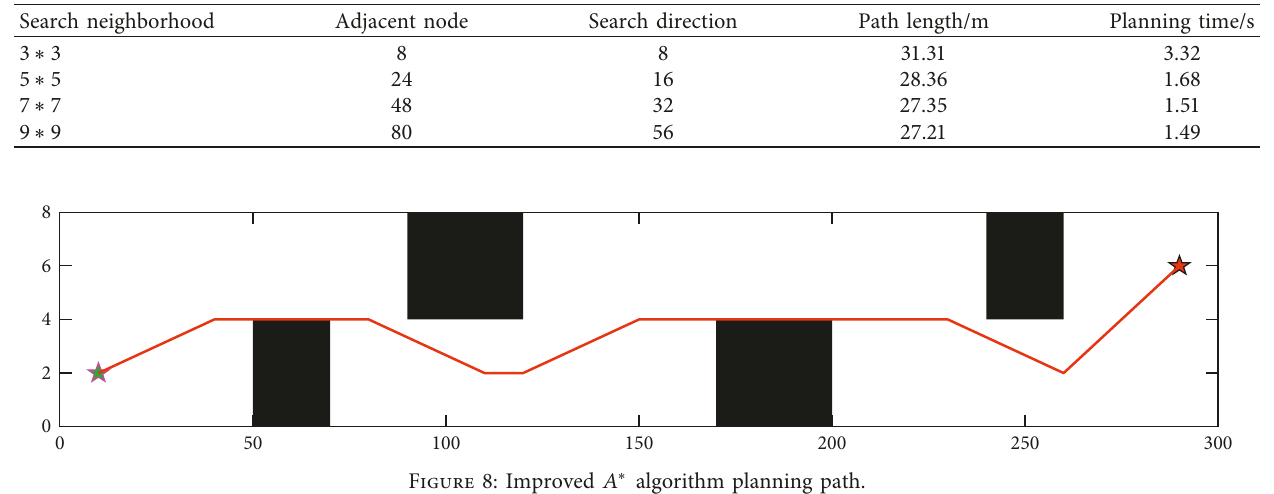
Table 1: Different search neighborhood planning results.